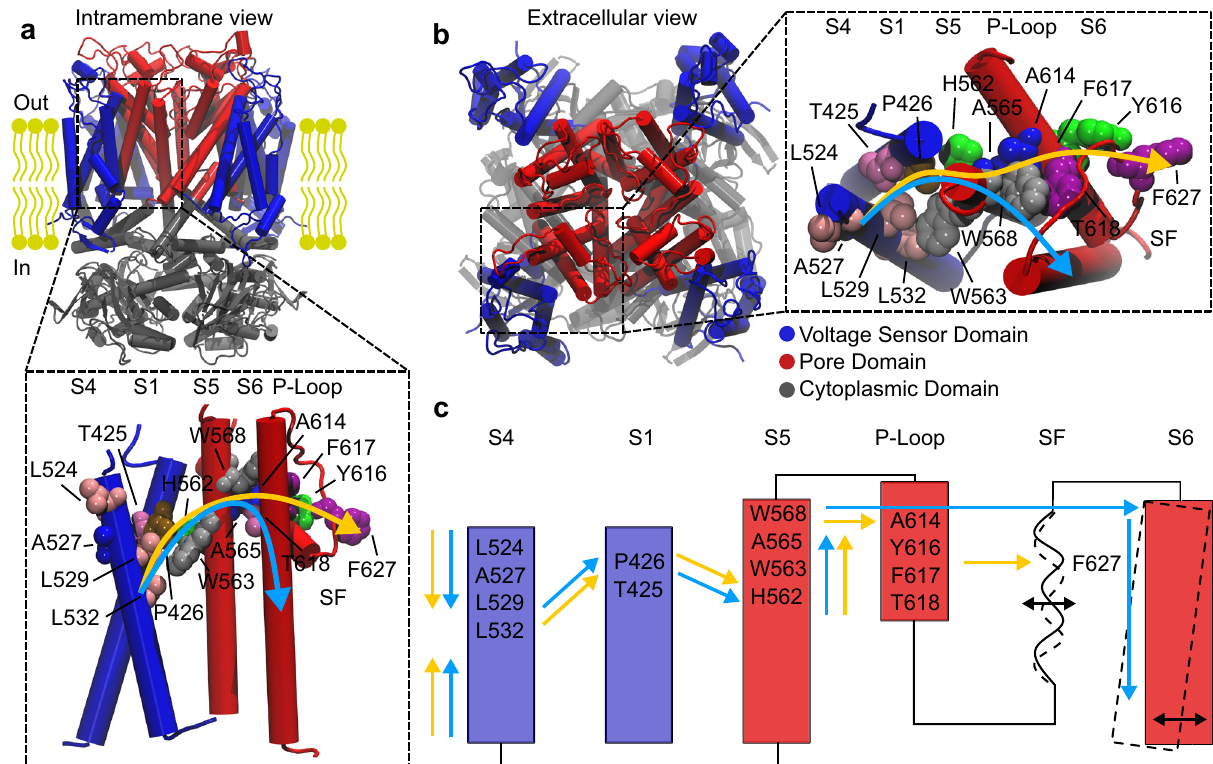
Fig. 1 | Molecularbasisforthenoncanonicalgating pathsinthehERG channel. Panels a and b show the intramembrane and extracellular views of the open state from MD simulations of the wild type 24 colored by domains: VSD in blue, PDin red andcytoplasmicdomainingray.Panel c schematizesthenoncanonicalpathsfound by simulations and involved in the activation (blue arrows) and in the inactivation (yellow arrows) that couple S4-S6 and S4-SF, respectively. The residues identi fi ed using the network analysis with the highest values of betweenness centrality (see also Supplementary Table 1)thatare involvedin the noncanonicalgating paths are